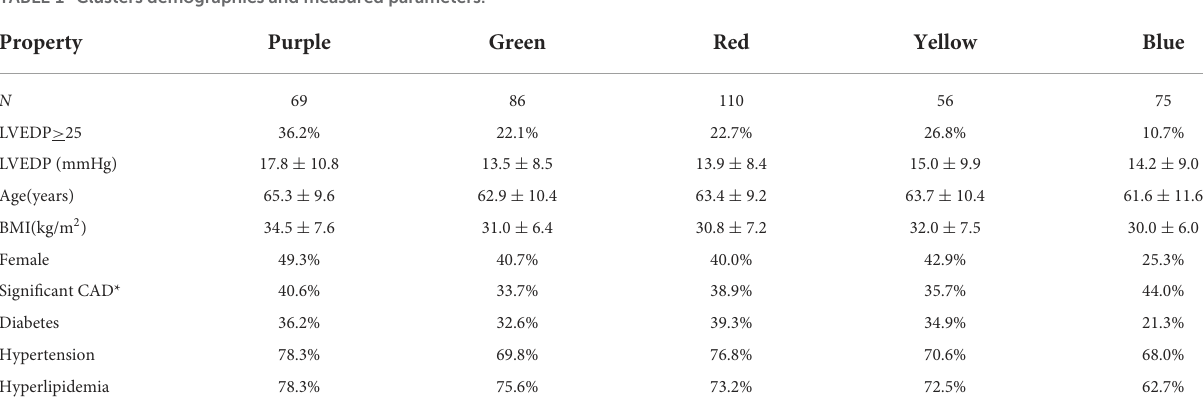
TABLE 1 Clusters demographics and measured